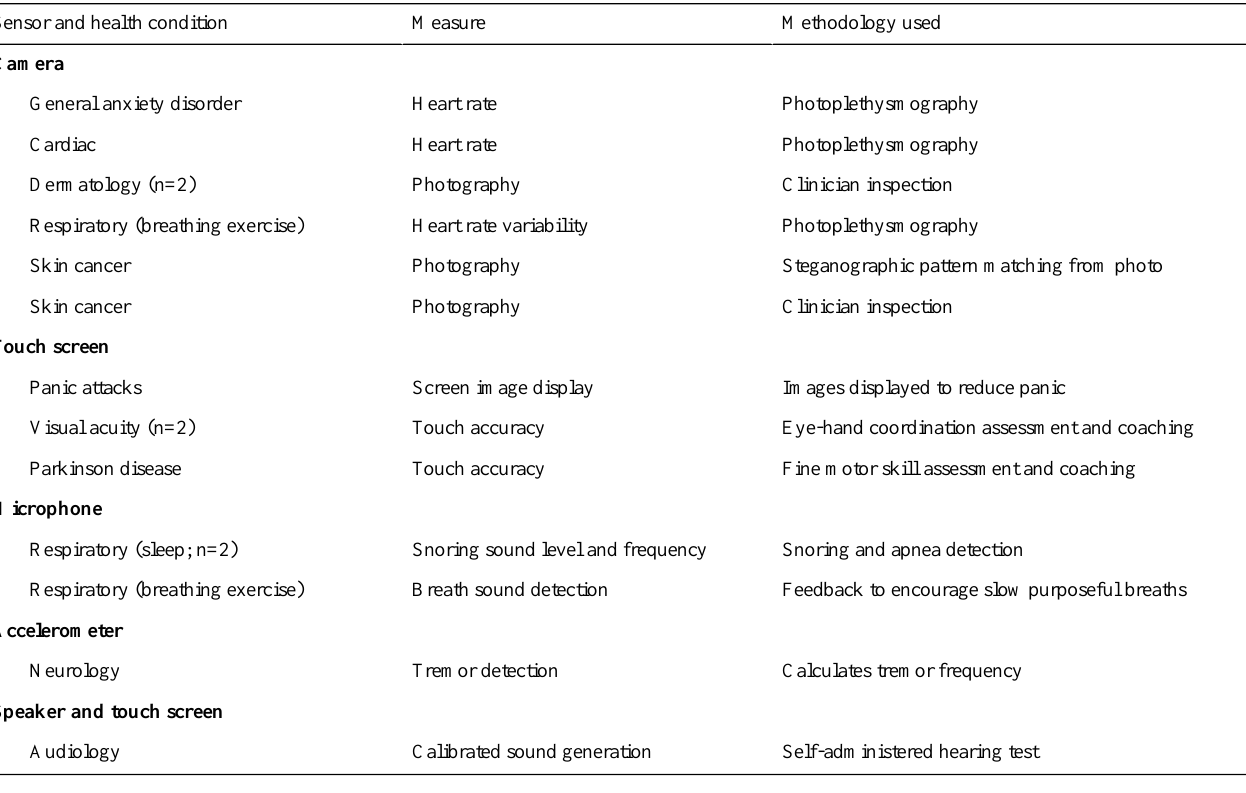
Table 6. Sensors, health conditions, and methodologies